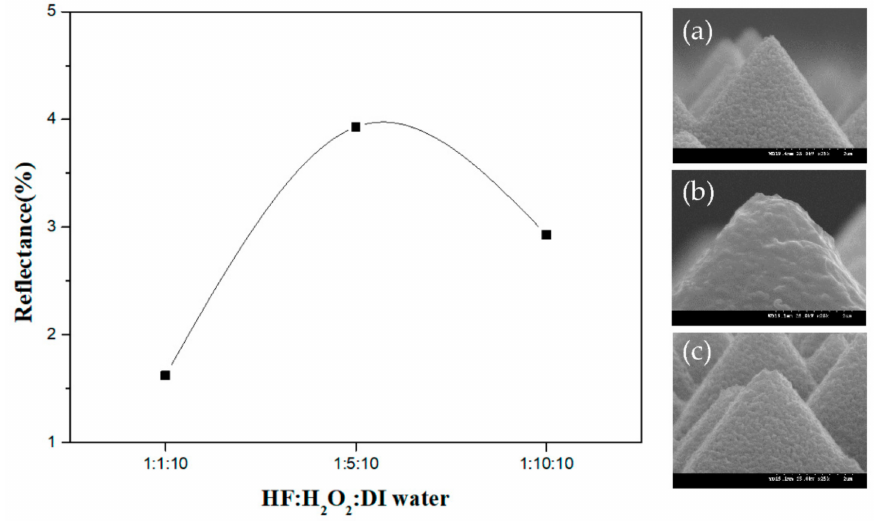
Figure 9. Reflectance and cross-section SEM images of wafer surfaces according to ρ for the two-step etching process with alkali solution and MACE: ( a ) ρ 50%, ( b ) ρ 16.6%, and ( c ) ρ